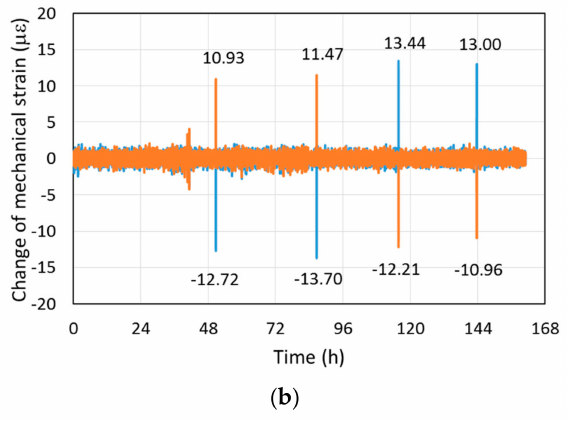
Figure 11. The concrete beam test: ( a ) mechanical strain; ( b ) change in mechanical strain per unit time.